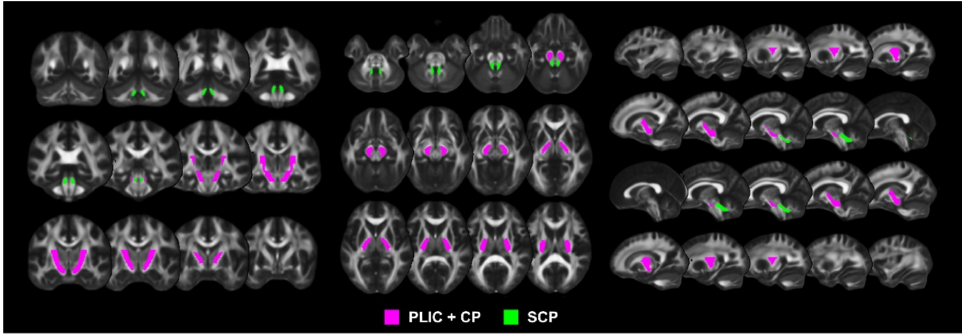
Figure 2. PLIC, CP, and SCP regions extracted from the JHU ICBM-DTI-81 Atlas. PLIC, posterior limb of the internal capsule; CP, cerebral peduncle; SCP, superior cerebellar